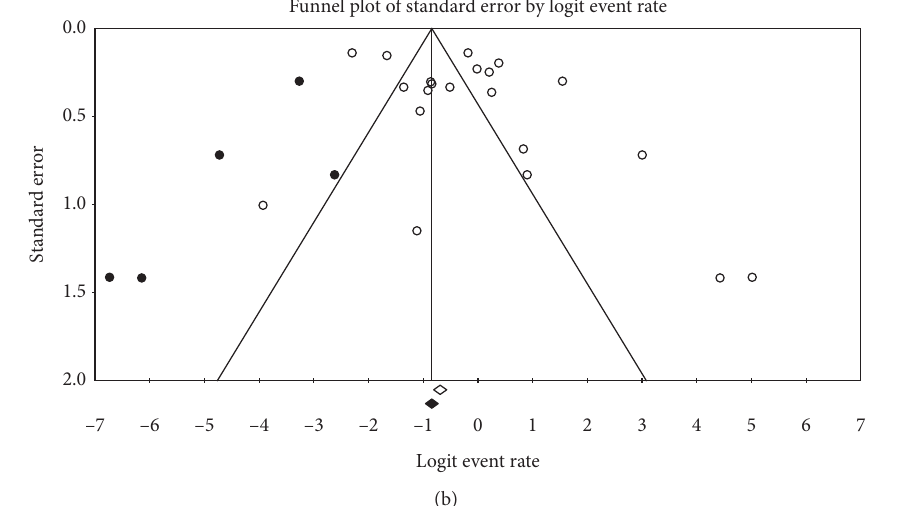
Figure 3: Forest plot (a) and funnel plot (b) showing the prevalence of penicillin-nonsusceptible S. pneumoniae in Iranian